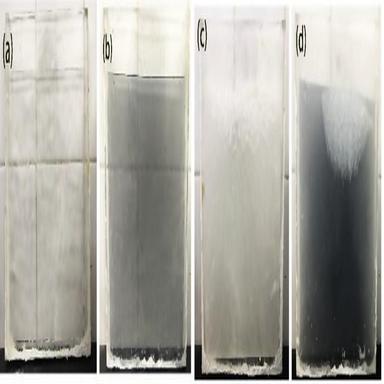
Digital photos of the liquid and solid state of CaCl2·6H2O window (a, c) and CaCl2·6H2O/CsxWO3 window (b, d).